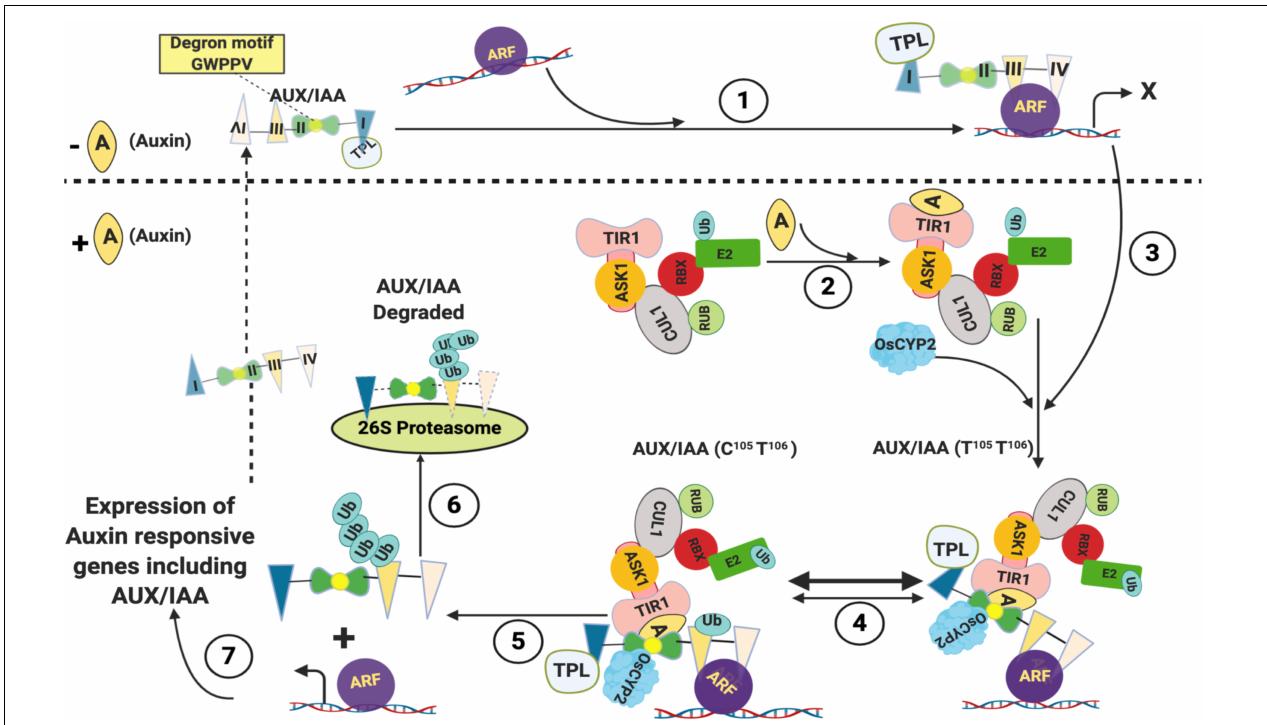
FIGURE 2 | Role of cyclophilins in regulation of Auxin-responsive genes. At low levels of Auxin, Aux/IAA proteins bind to auxin response factors (ARFs) directly or through recruitment of transcriptional corepressor such as TOPLESS (TPL) and inhibit their activity (1). When present at high levels, the auxin binds to its receptor TRANSPORT INHIBITOR RESPONSE1 (TIR1) and enhances its interaction with the highly conserved ’degron’ motif GWPPV in domain II of Aux/IAAs (2 and 3). The Aux/IAA proteins bind to SCFTIR1-Auxin complex only when W104-P105 isomer in the ’degron’ motif GWPPV (residues 103, 104, 105, 106 and 107, respectively, in rice) is in cis conformation. The trans conformer of W-P (T105-T106) in the ’degron’ motif is catalyzed to cis form (c105-T106) by OsCYP2 (4). The Aux/IAA-SCFTIR1 complex leads to ubiquitination of Aux/IAA proteins (5), which are then degraded by 26S Proteasome (6), leading to expression of Auxin responsive genes including Aux/IAA (7) (Adapted from Tan et al., 2007; Mockaitis and Estelle, 2008; Jing et al., 2015; Created with